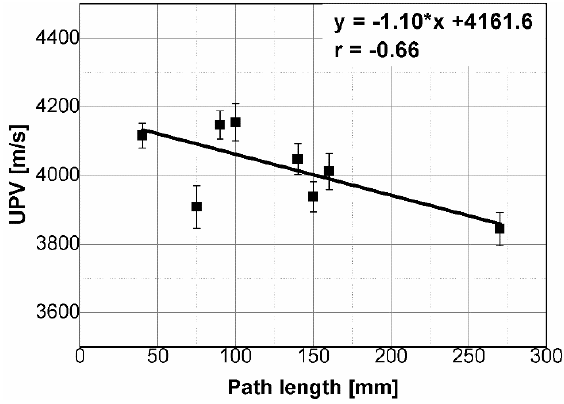
Figure 7. Pulse velocity plotted against path length.